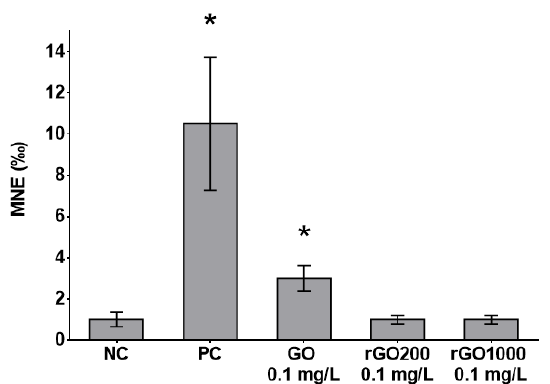
Figure 5. Micronucleus induction measured in erythrocytes of Xenopus laevis larvae exposed for 12 days to GO or rGO (rGO200 or rGO1000). MNE: micronucleated erythrocytes; NC: negative control; PC: positive control; *: significant difference compared to the NC (McGill test).